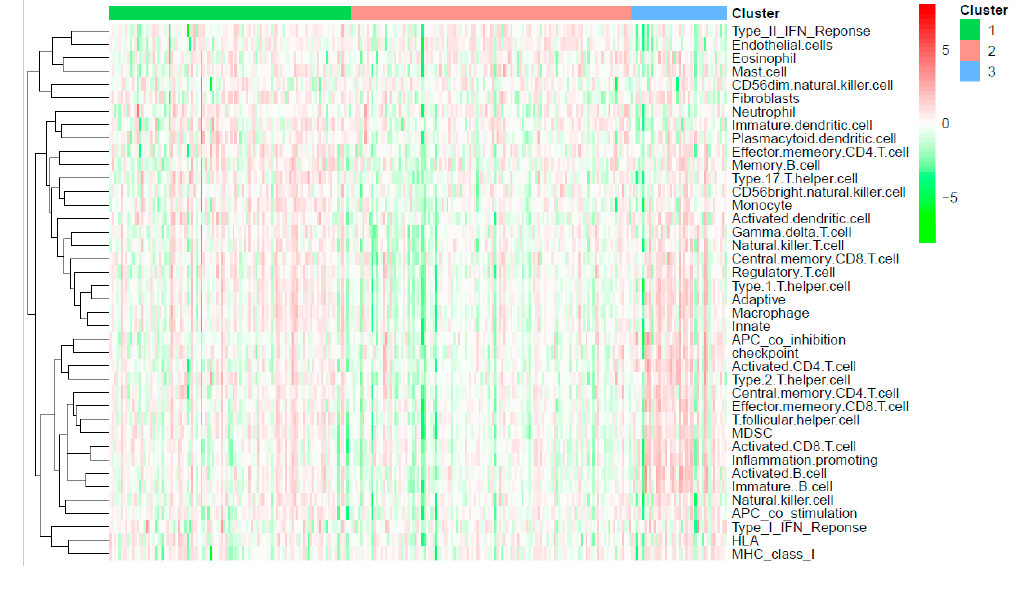
Figure 3. Distinct DNA methylation and gene expression level of each subtype. ( A ) Methylation level of each subtype. ( B ) Gene level of each